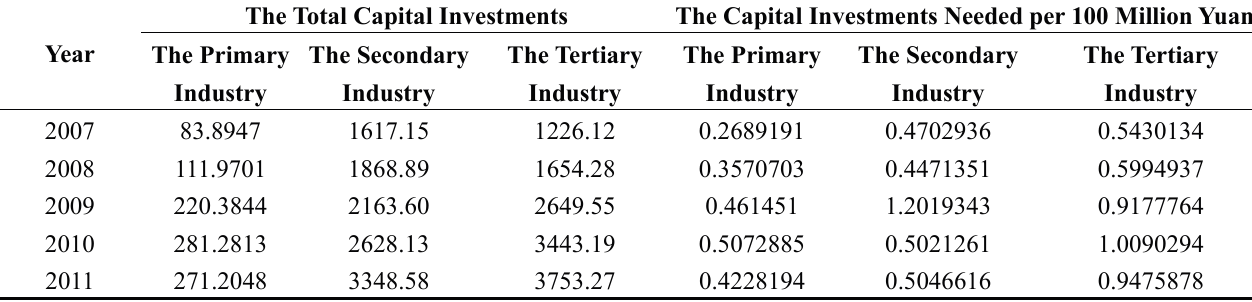
Table 3. The total capital investments and the capital investments needed per 100 million yuan in Shanxi Province from 2007 to 2011 (100 million yuan) [30–34].